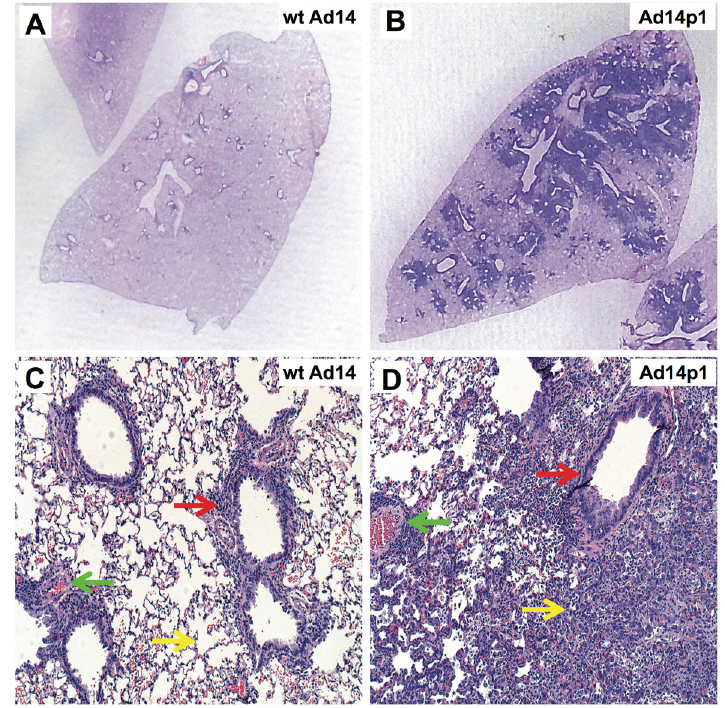
Figure 1. Comparative lung pathology induced by infection with prototype strain Ad14 (wild type, wt) vs. the outbreak strain, Ad14p1. Lungs were harvested from infected hamsters at 7 days after intratracheal viral inoculation (5 × 10 9 plaque-forming units per animal). A & B , hematoxylin and eosin (H&E)-stained lung section macroscopic comparison, showing minimal peribronchial changes in wt Ad14- infected lung ( A ) vs. marked peribronchial infiltrates in Ad14p1-infected lung ( B ). C & D , H&E comparisons at 10X magnification. Green, yellow, and red arrows indicate perivascular, alveolar, and peribronchial inflammation, respectively, in wt Ad14-infected lung ( C ) vs. Ad14p1-infected lung ( D ). Adapted with permission from American Society of Microbiology. Copyright © American Society for